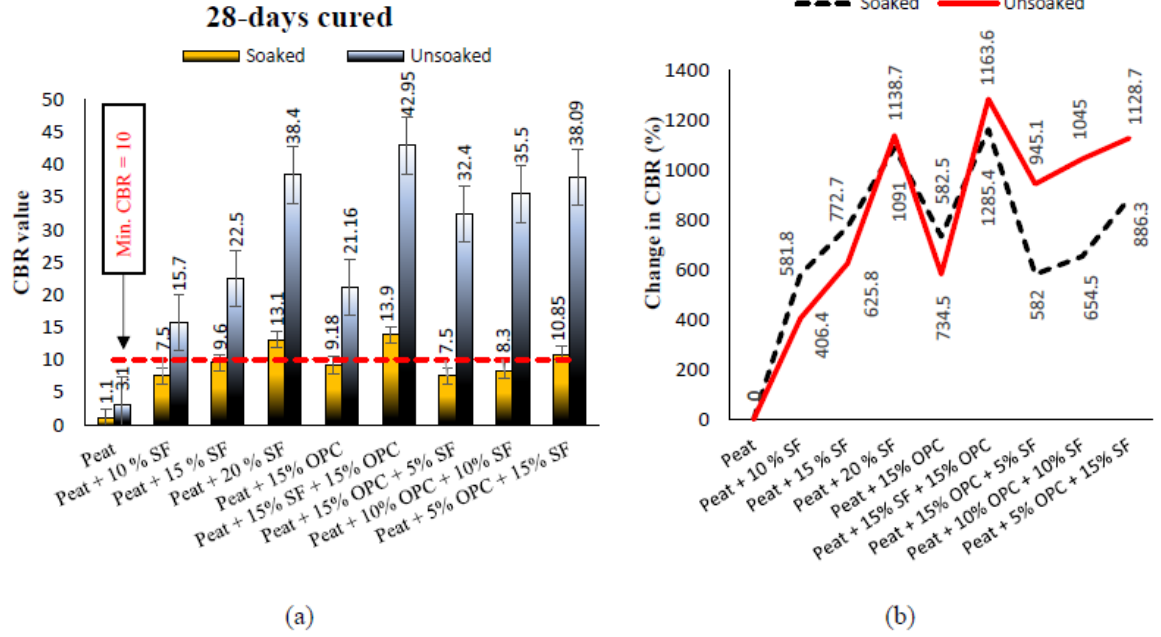
Figure 11. ( a ) The 28 days cured soaked and unsoaked CBR values of treated and untreated Teluk Intan peat; ( b ) changes in the soaked and unsoaked CBR values after treatment.